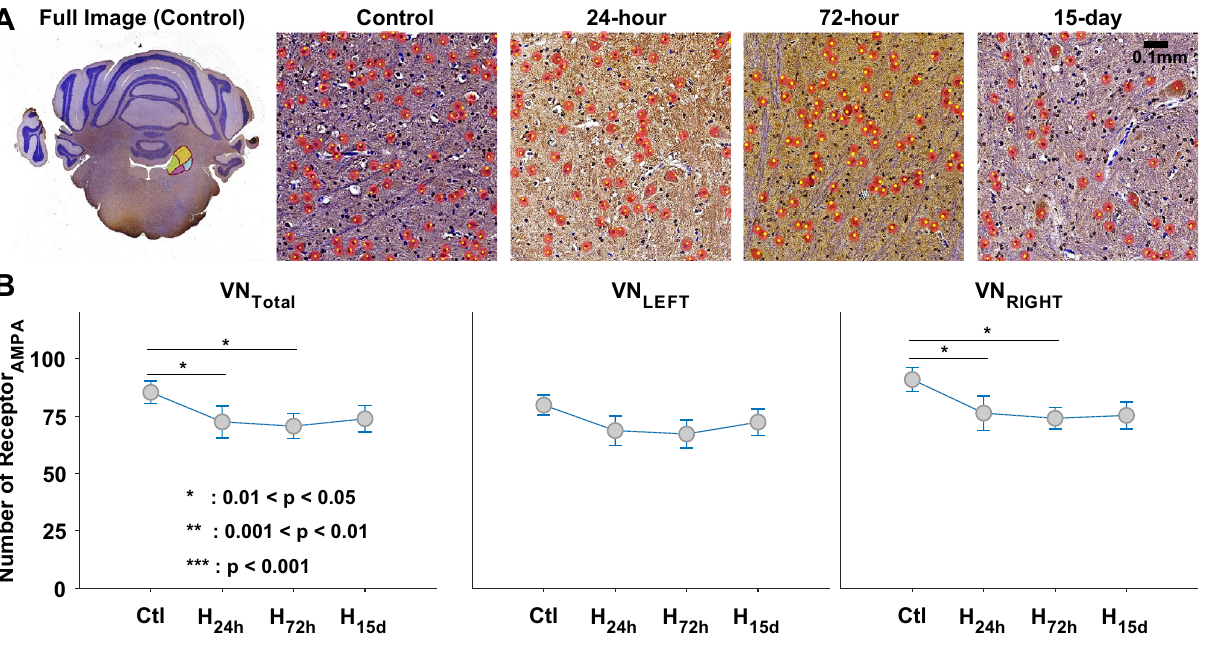
Figure 5. A full coronal image of the brain with the position of vestibular nucleus (VN), and the detected AMPA receptors (AMPAr) in control, 24-h, 72-h, and 15-day ( A ). Total number of AMPAr in overall, left, and right sides of VN ( B ). (*0.01 < p < 0.05, **0.001 < p < 0.01, *** p < 0.001).